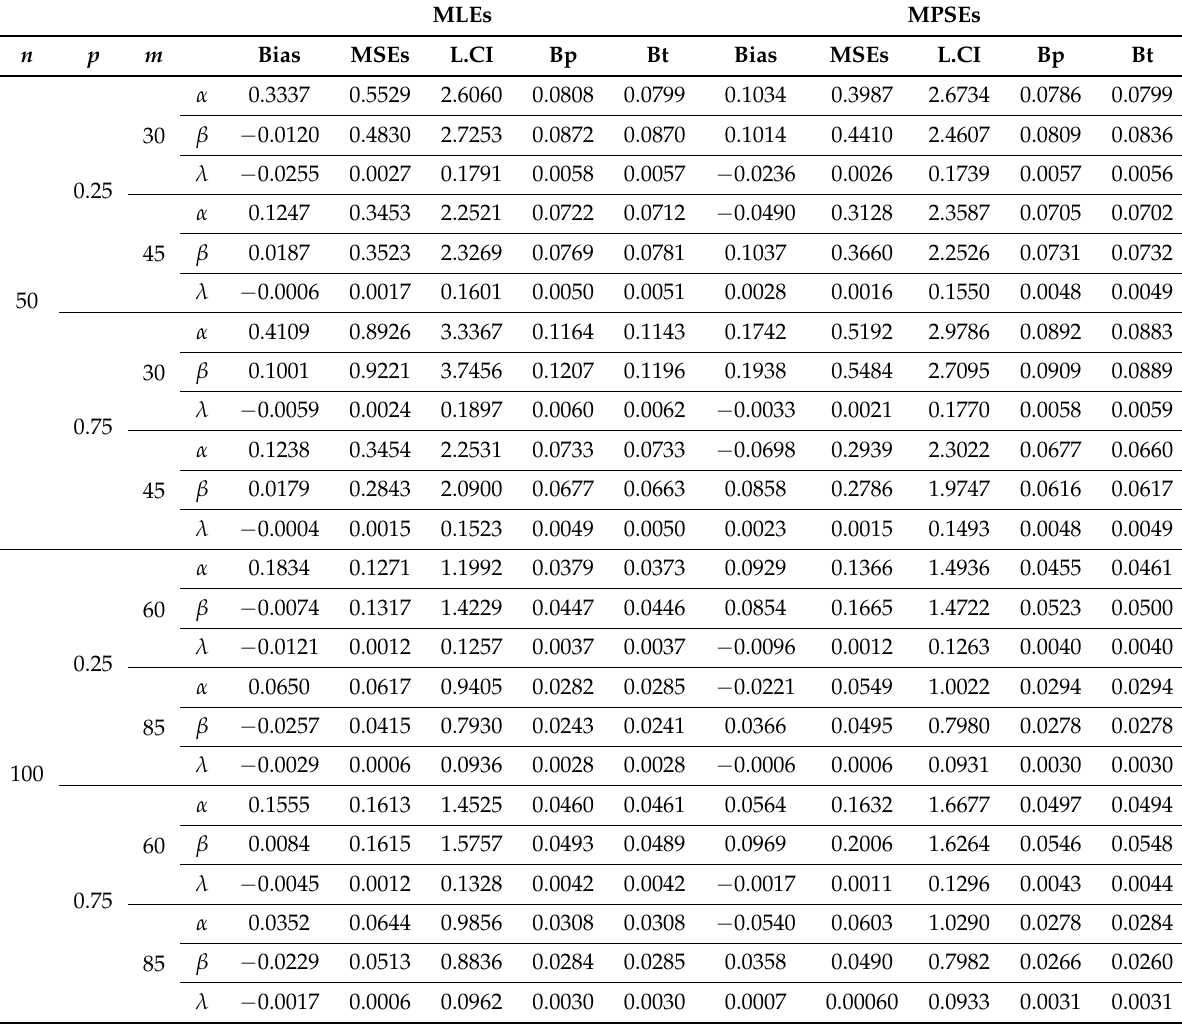
Table 2. The MLEs and MPSEs of the EOWE parameters under progressive type-II censoring scheme with binomial removals for Case